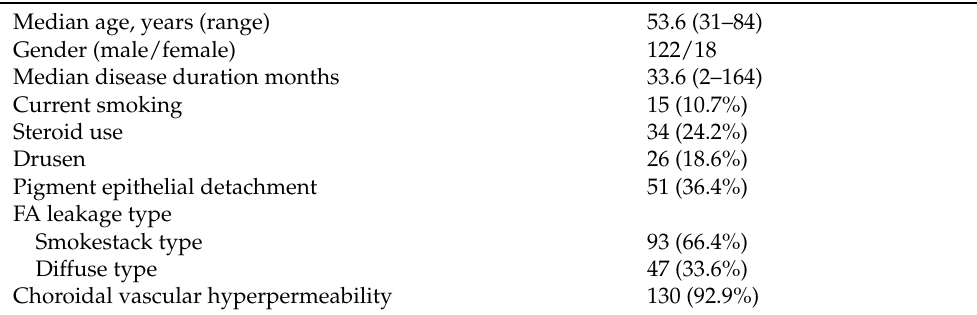
Table 1. Characteristics of 140 patients.